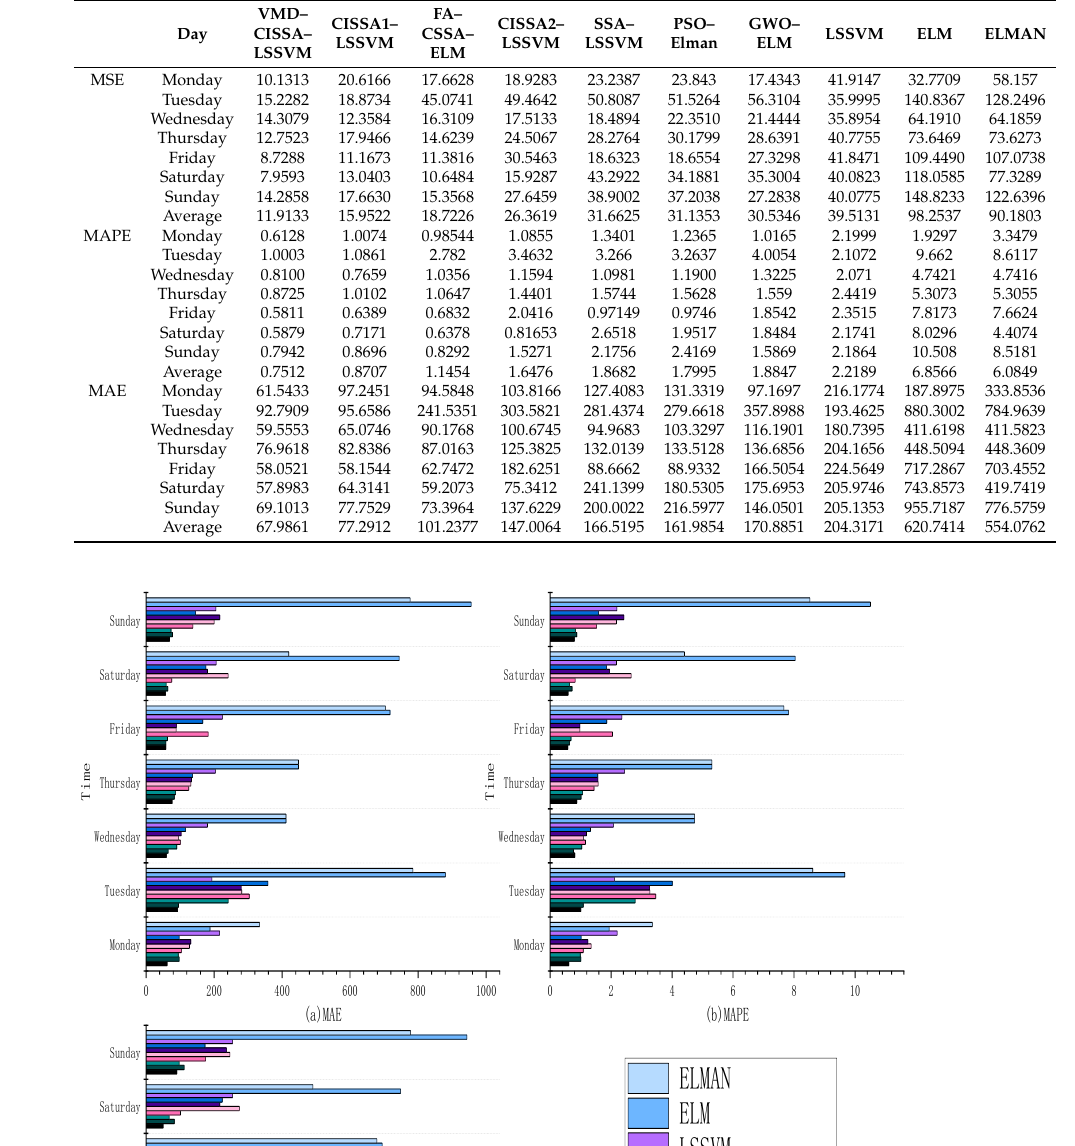
Table 8. Evaluation index statistics of different power load competition models.